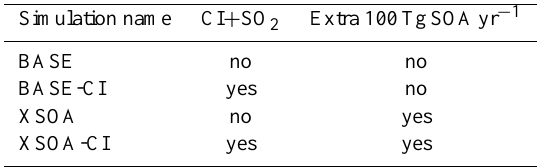
Table 2. Sources and sinks of CIs in the BASE-CI and XSOA-CI simulations (same for both